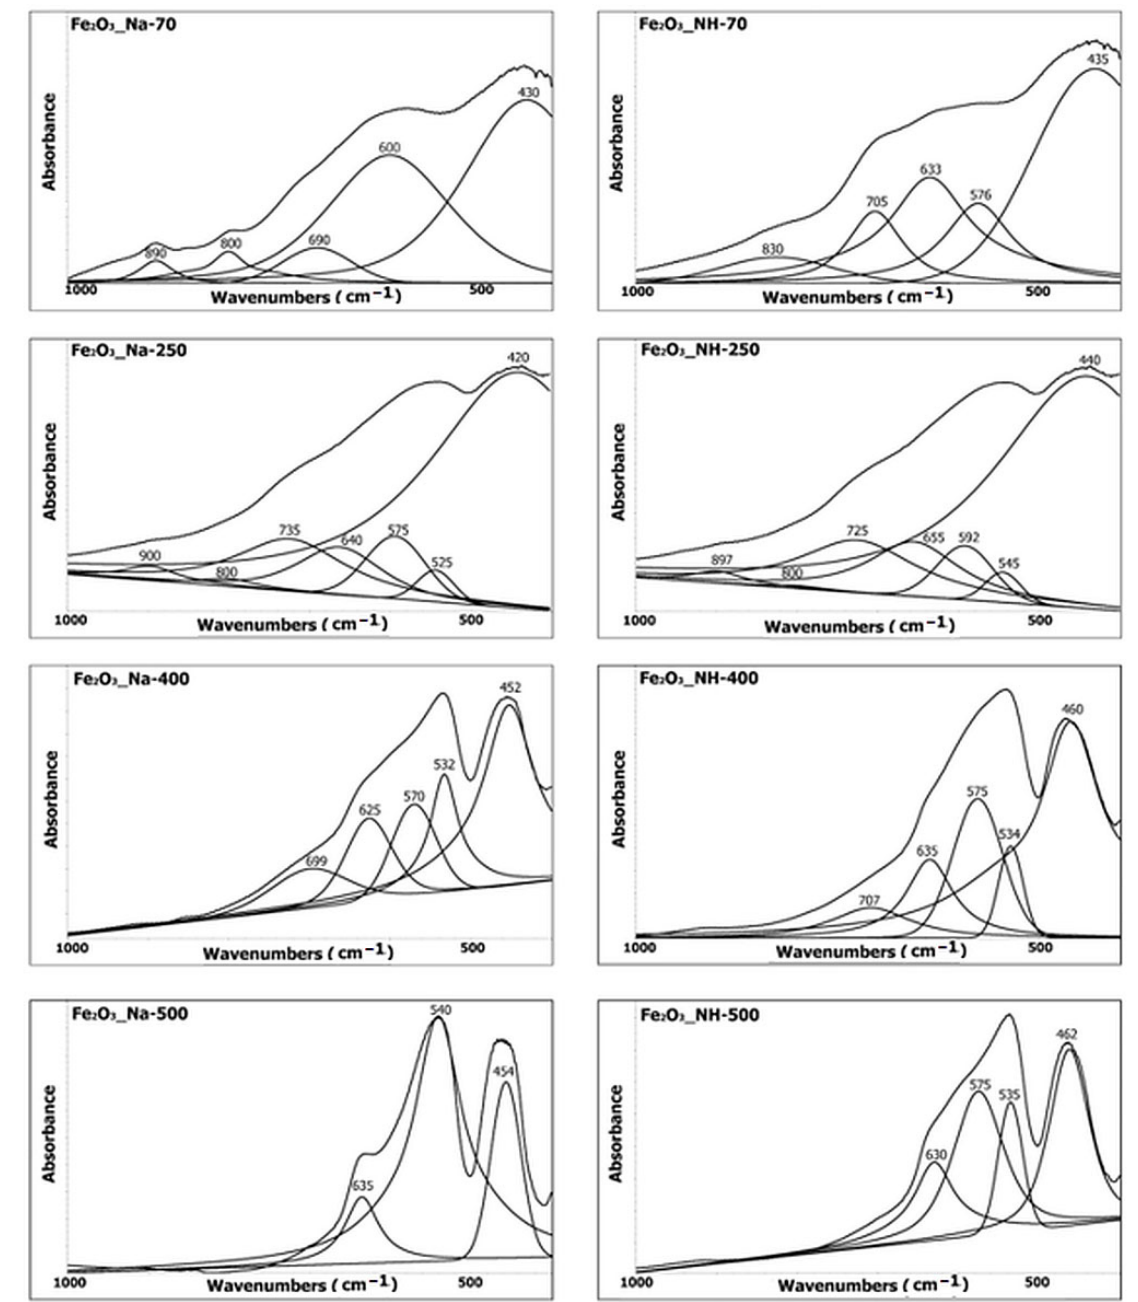
Figure 8. IR spectral bands below 1000 cm − 1 .